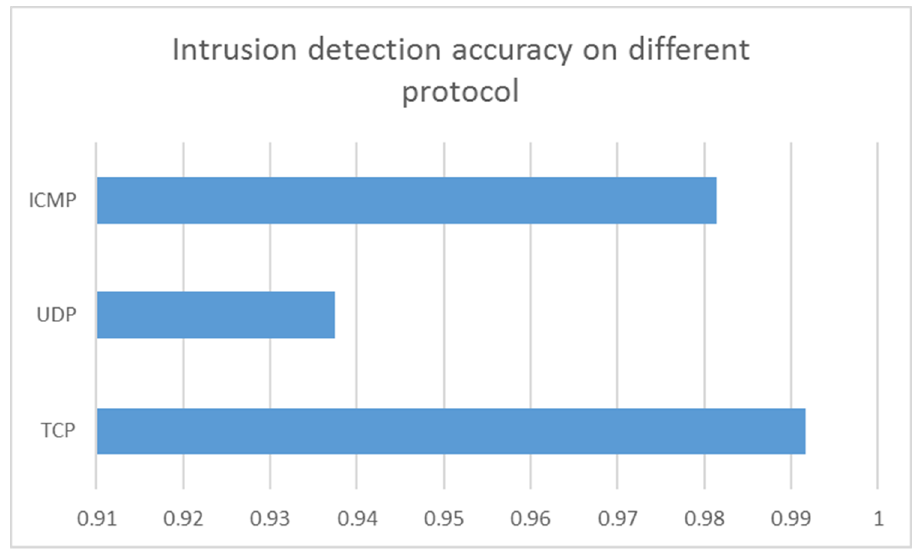
Figure 8. Accuracy on different protocols.